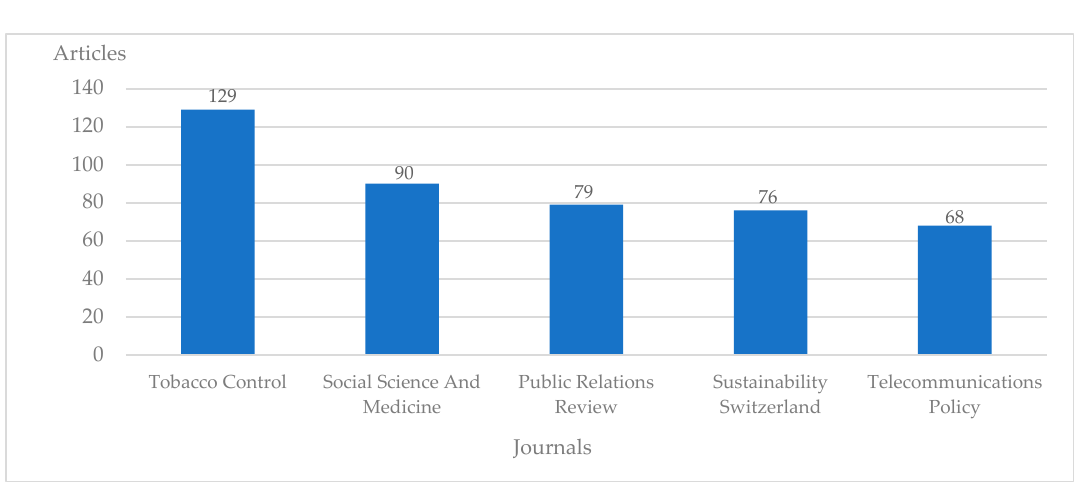
Figure 3. Journals with more articles published.